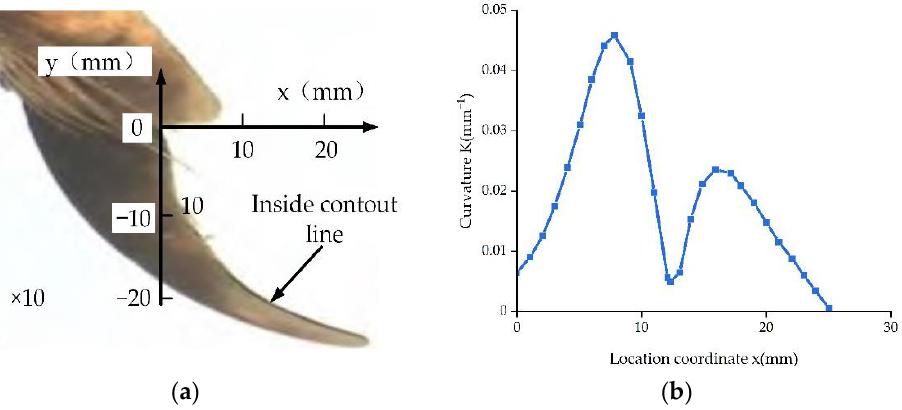
Figure 8. Inner-contour line geometric features of vole claw toe. ( a ) Photograph of the middle toe of a vole’s right front claw; ( b ) the curvature change trend line of the inner contour. Table 9. Structure parameters of soil-engaging surface of the test bulldozing